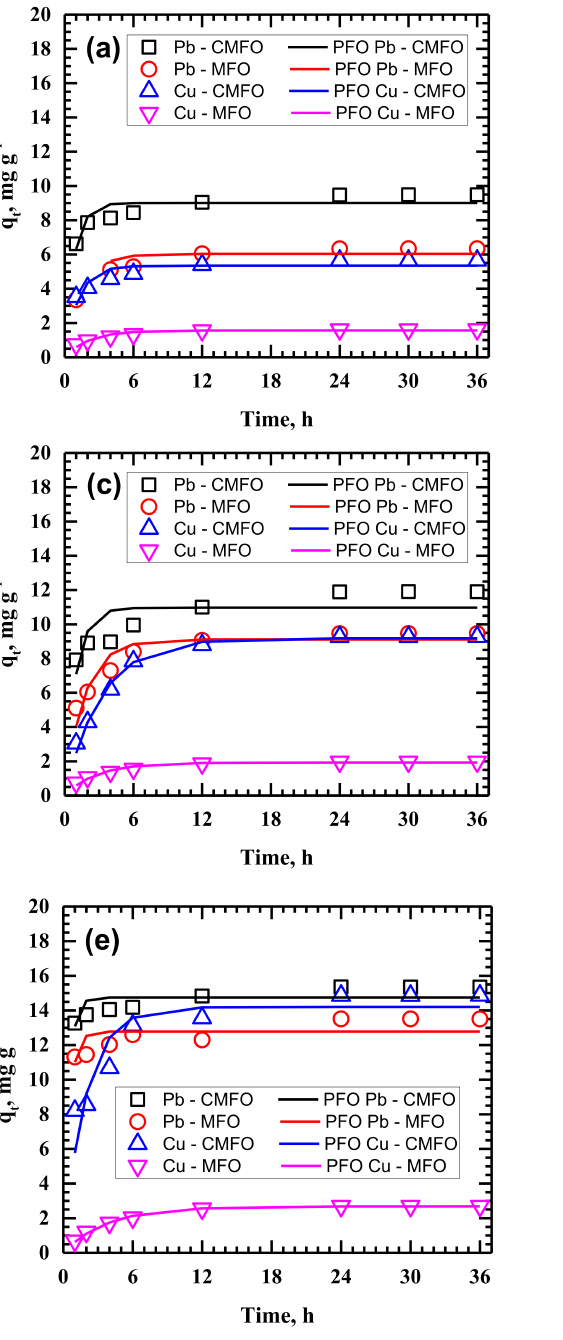
Figure 3. Nonlinear fitting of pseudo-first-order and pseudo-second-order kinetic models for Cu(II) or Pb(II) uptake by CMFO or MFO at different solution temperatures: ( a , b ) 25 ◦ C, ( c , d ) 35 ◦ C, and ( e , f ) 45 ◦